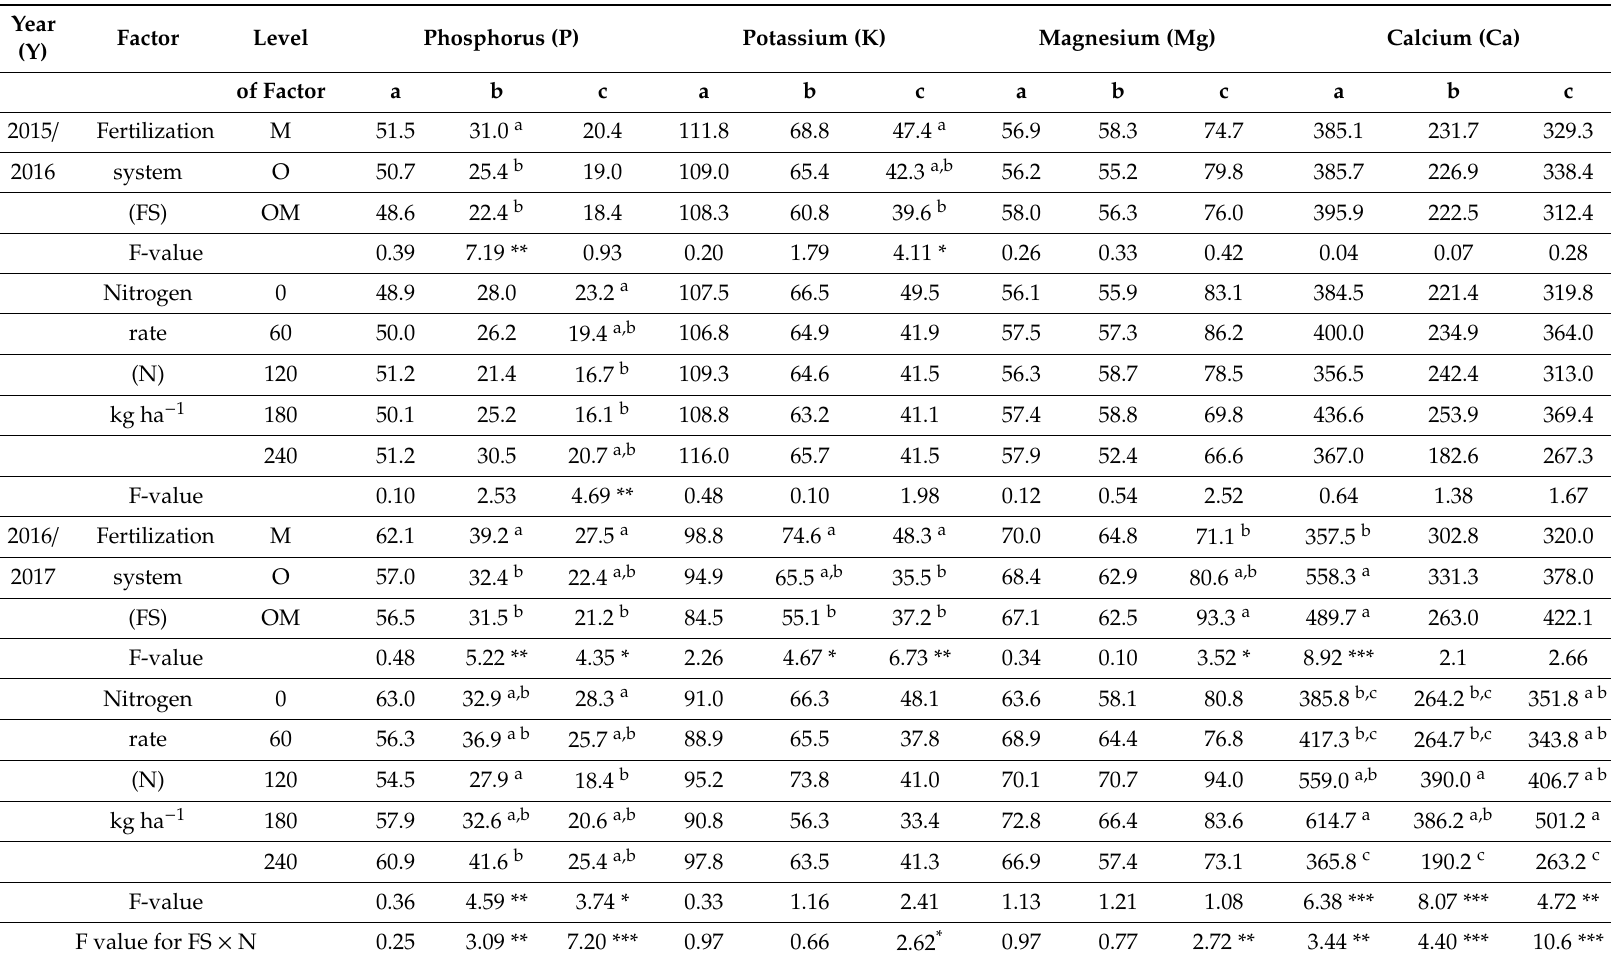
Table 4. The content of available nutrients along the soil layers at the onset of stem elongation of winter oilseed rape (BBCH 30), mg kg − 1 soil.